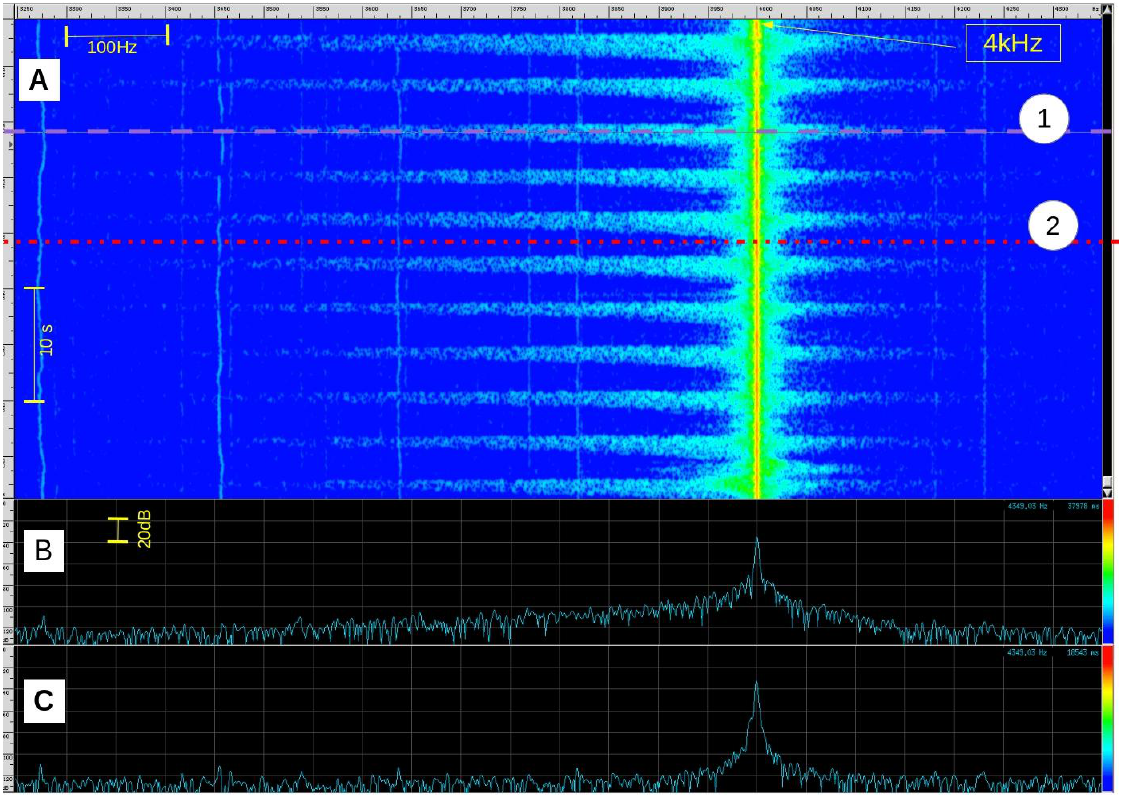
Figure 3. Signal visualization during rest and expiration phases. On top ( A ) a time (vertical) to frequency (horizontal) representation around the incident frequency pick. On bottom ( B ) the spectrum module during an expiration phase (1) and ( C ) the spectrum module during a rest phase (2), expressed in